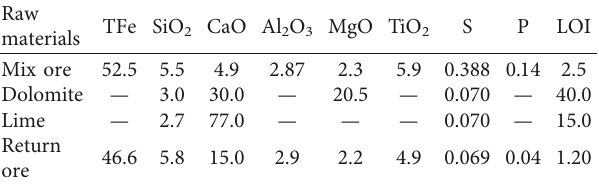
Table 1: Chemical composition of raw materials.